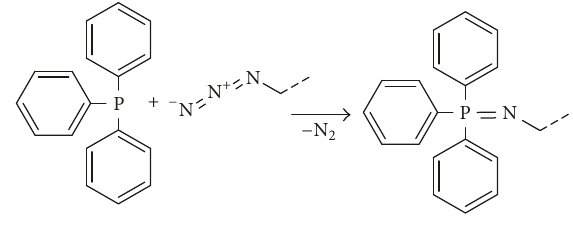
Figure 6: Scheme of the Staudinger